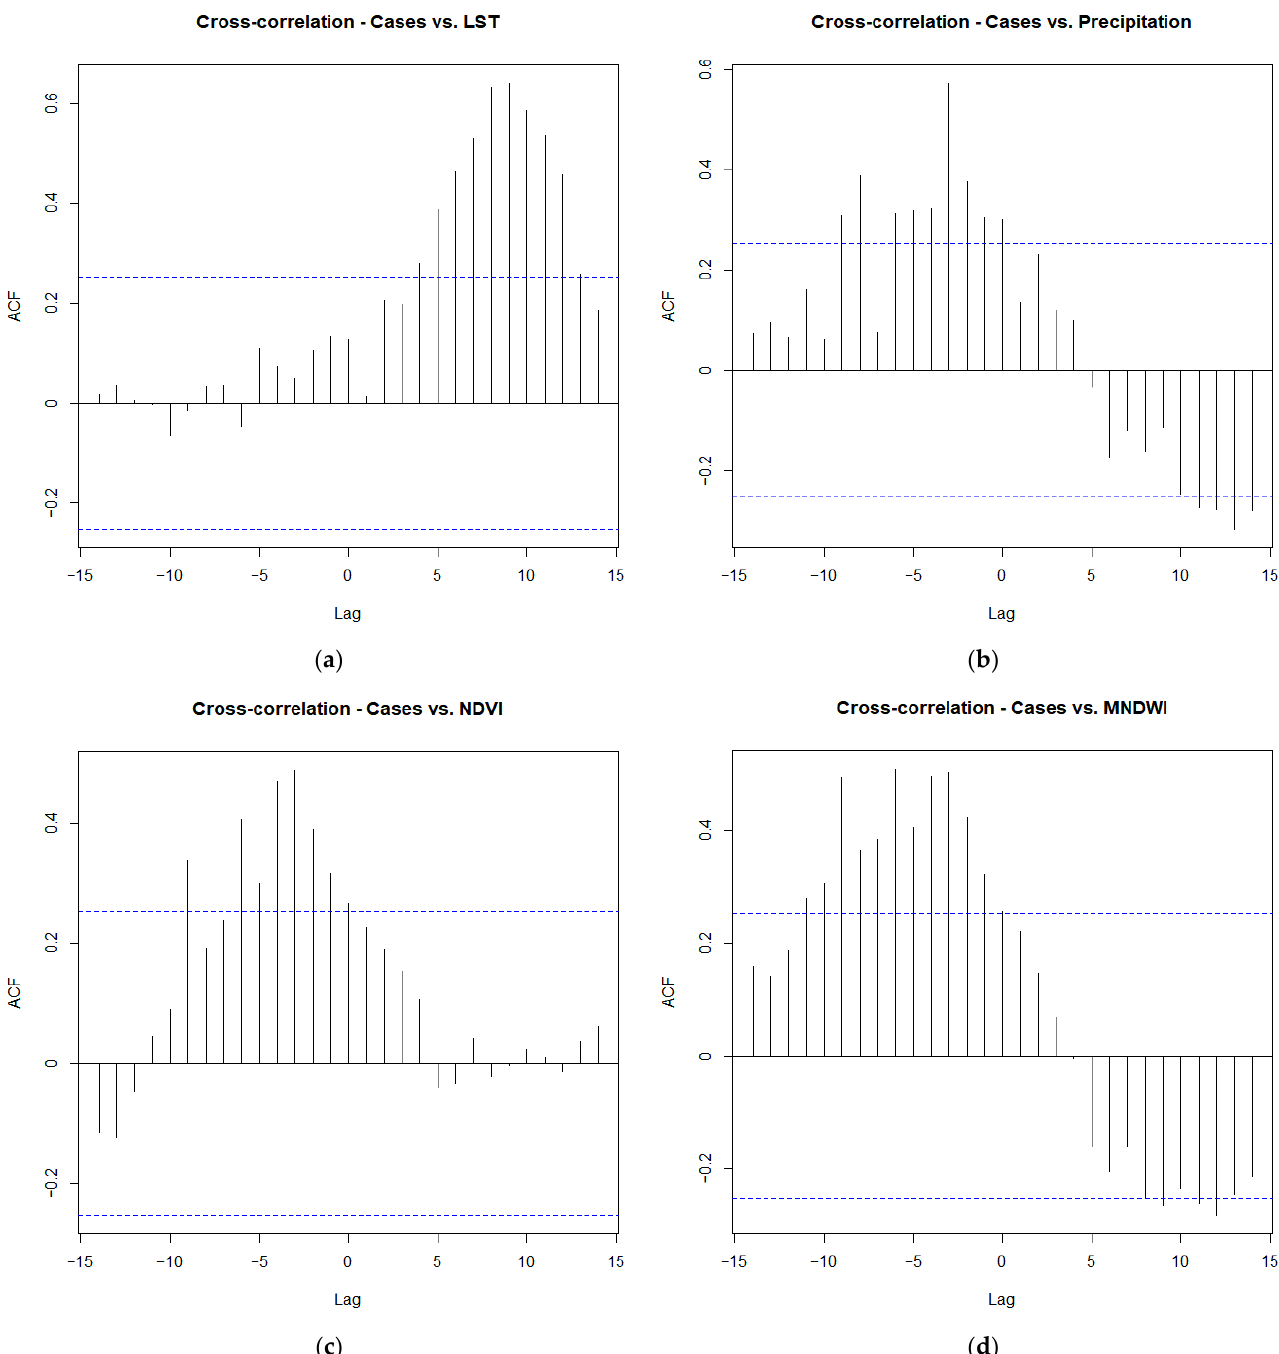
Figure 3. Cross-correlation time lag effects between HEV cases and ( a ) LST, ( b ) precipitation, ( c ) NDVI, and ( d ) MNDWI.